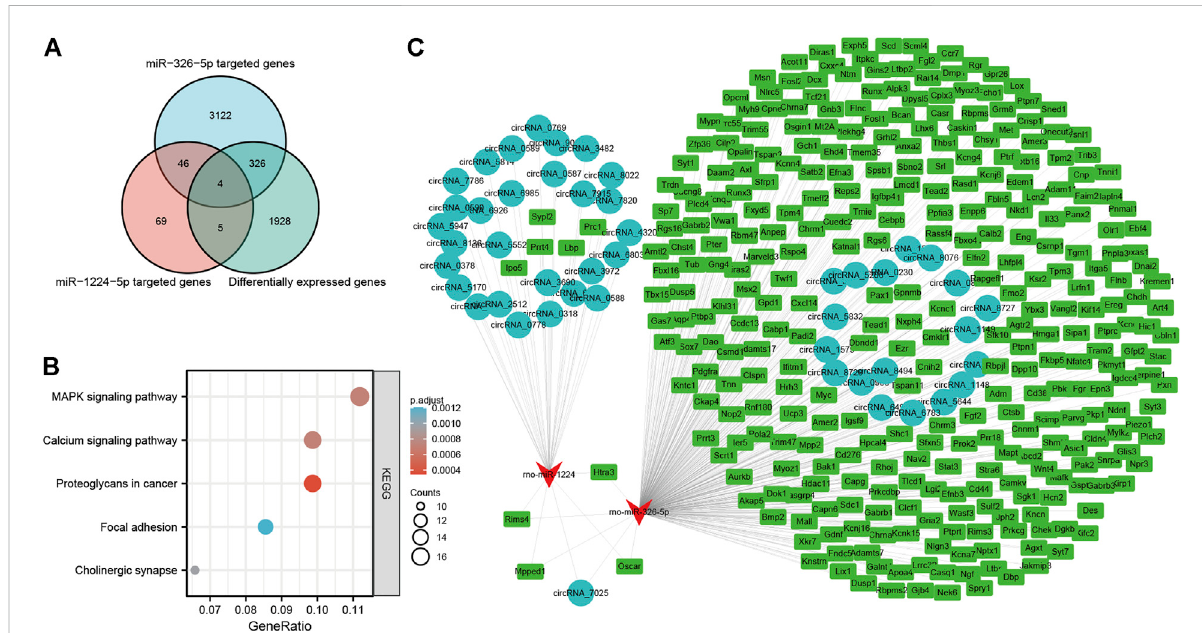
FIGURE 6 Construction of apoptosis-related circRNA-miRNA-mRNA network. (A) Venn diagram of differentially expressed mRNAs targeted by rno-miR- 1224 and rno-miR-326-5p. (B) KEGG pathway analisis of differentially expressed mRNAs targeted by rno-miR-1224 and rno-miR-326-5p. (C) The apoptosis-related circRNA-miRNA-mRNAs interaction network of rno-miR-1224 and rno-miR-326-5p, and their targeted circRNAs and mRNAs. circRNAs, circular RNAs, miRNAs: microRNAs; mRNAs. messenger RNAs; KEGG, Kyoto Encyclopedia of Genes and